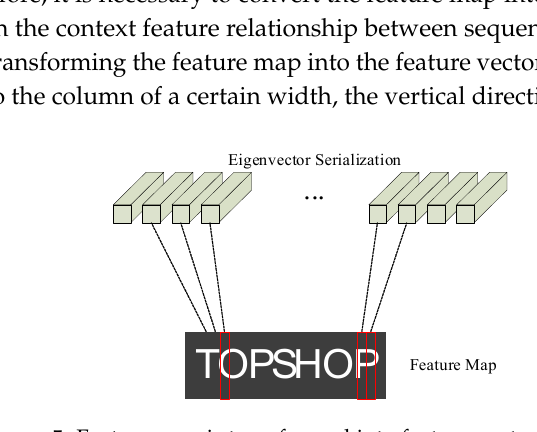
Figure 5. Feature map is transformed into feature vector sequence.